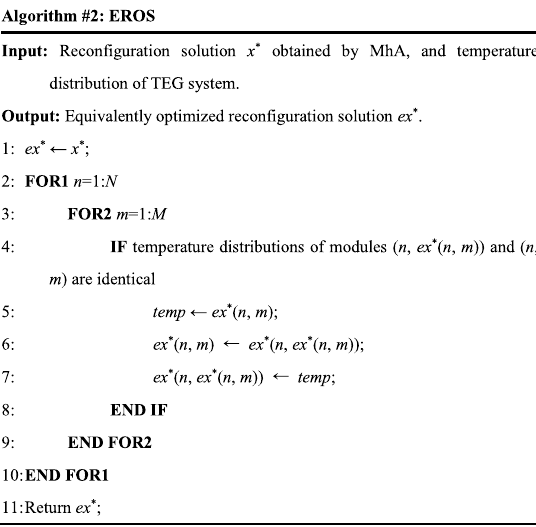
Table 2 The procedure of EROS for reconfiguration